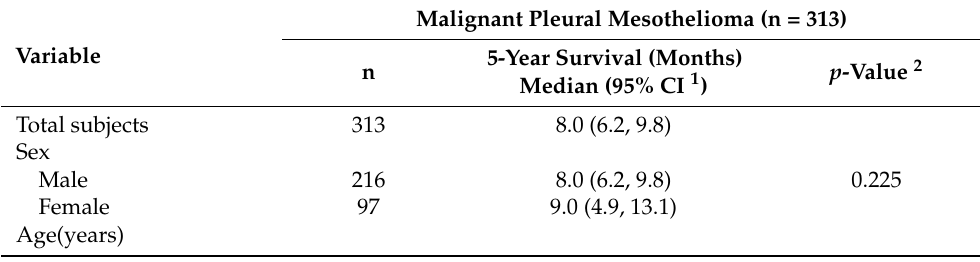
Table 2. The 5-year survival duration of malignant pleural mesothelioma according to potential prognostic